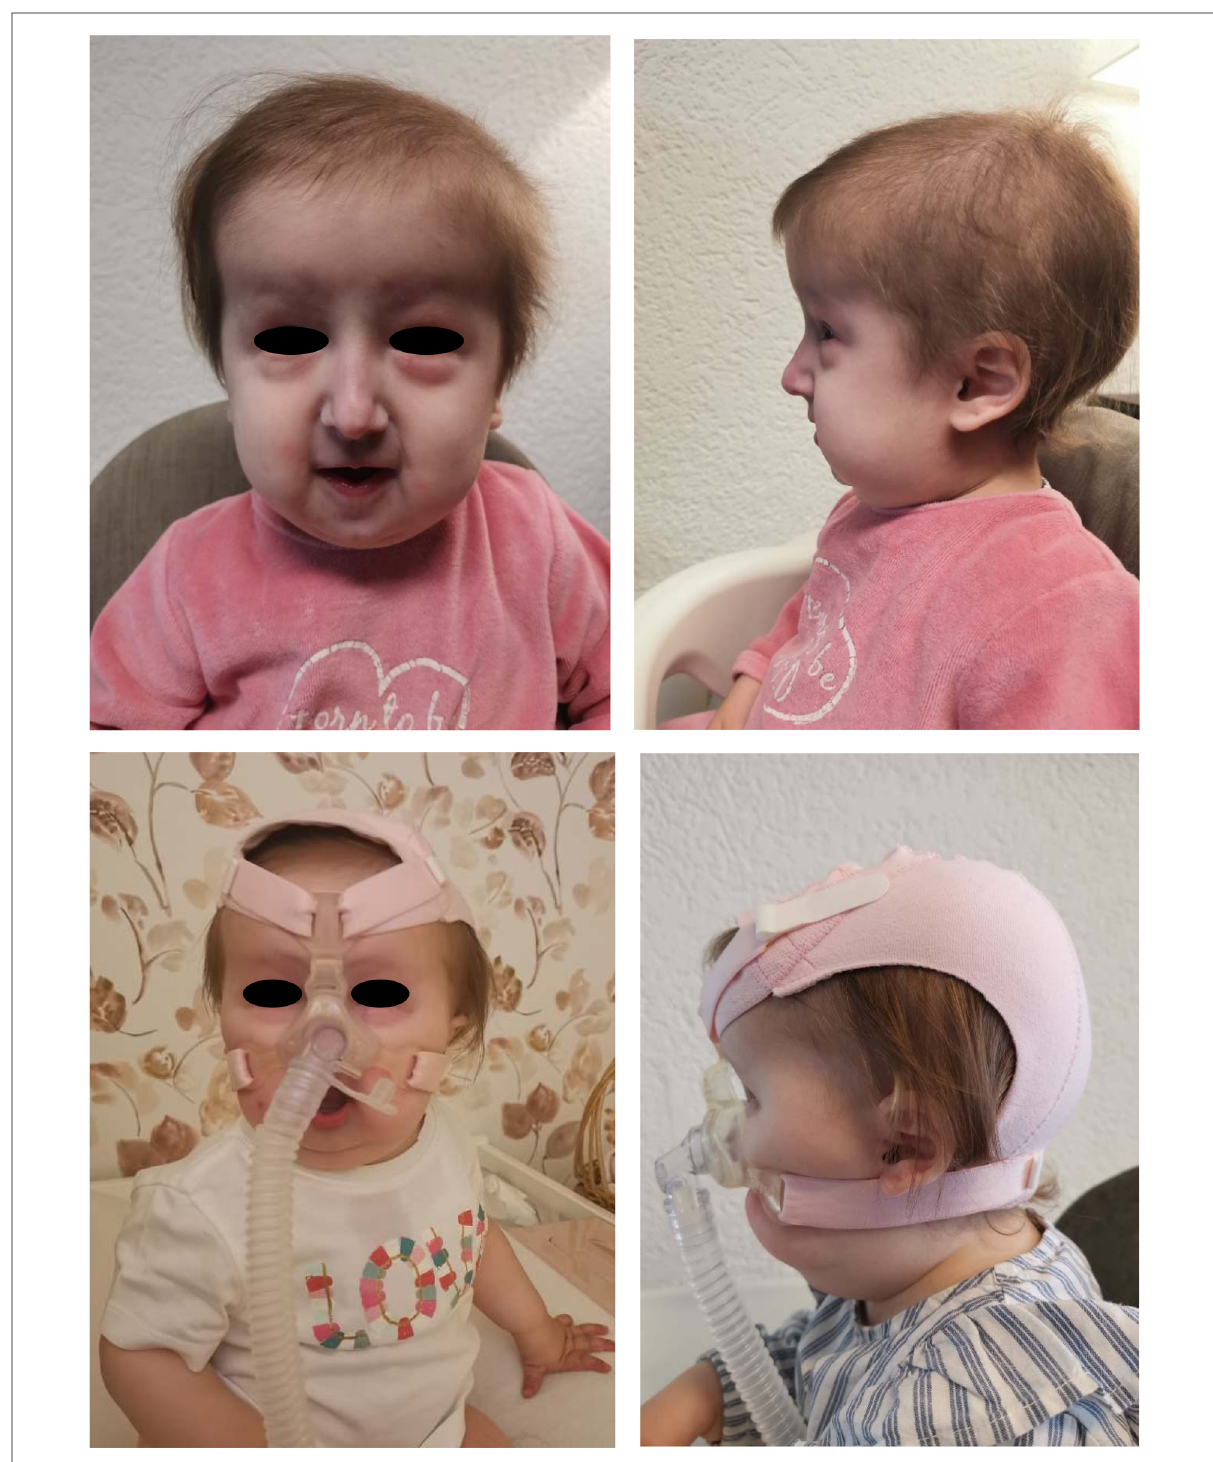
FIGURE 2 Current front and pro fi le photography, with and without